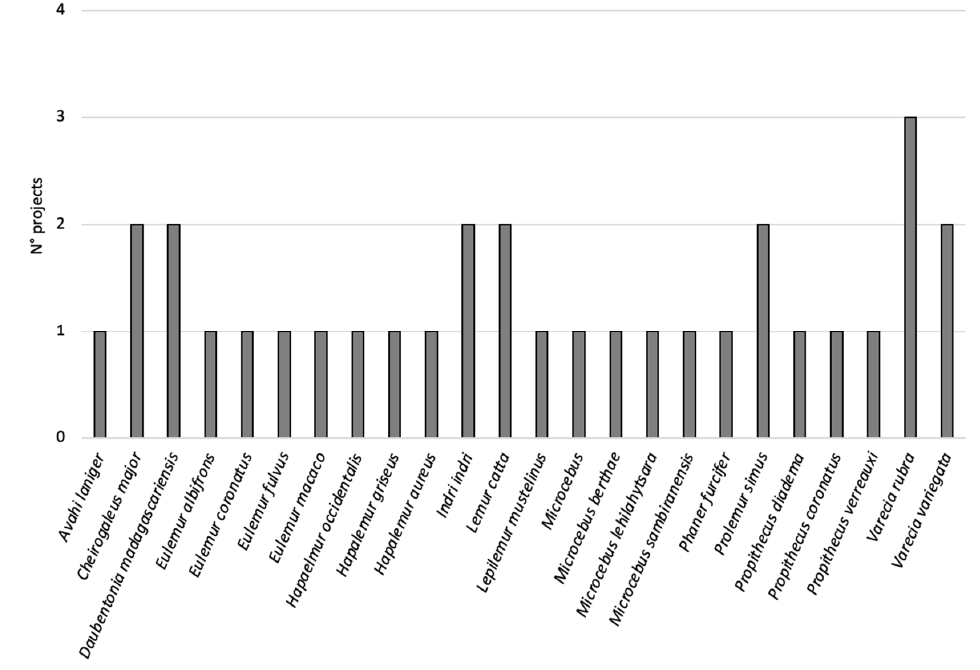
Figure 4. Lemur species involved in conservation projects.